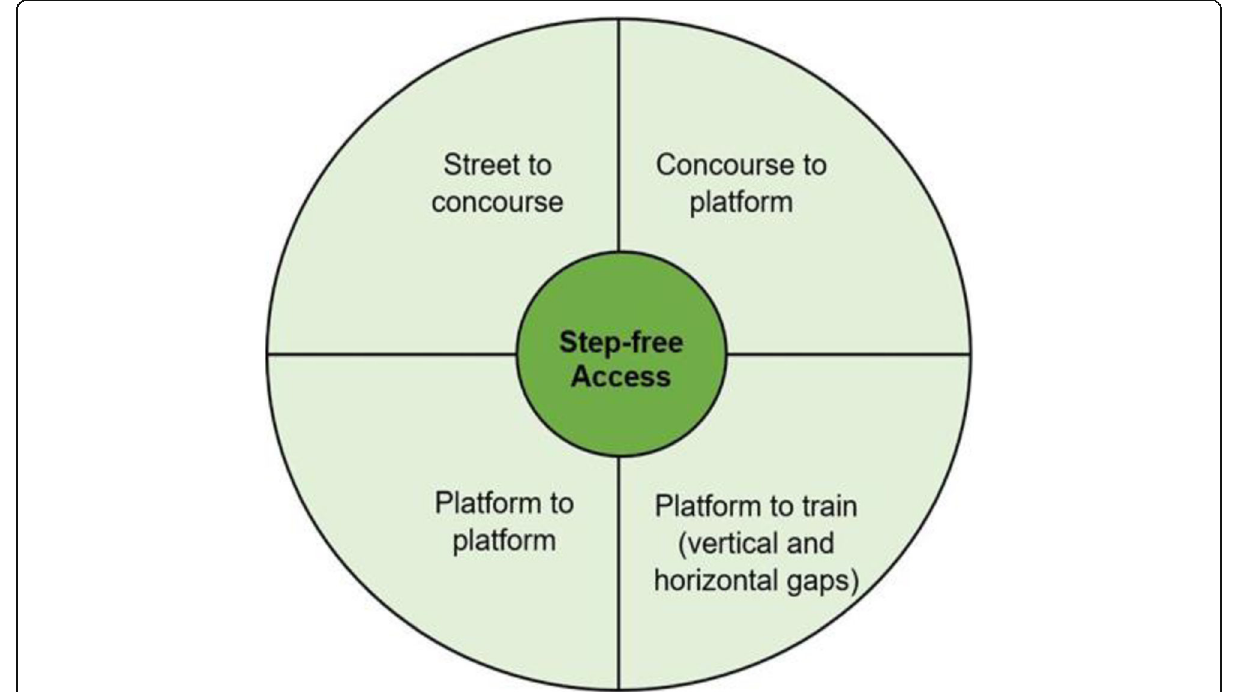
Fig. 3 Key elements of step-free access in an inclusive railway station design (Source: Authors ’